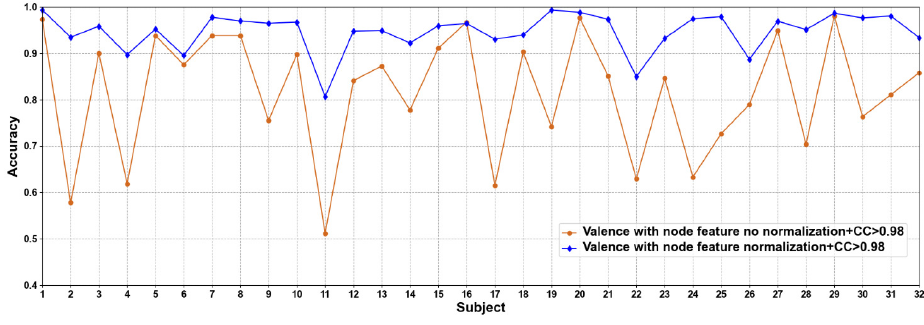
Figure 3. Classification accuracies on each subject on valence with/without normalization.